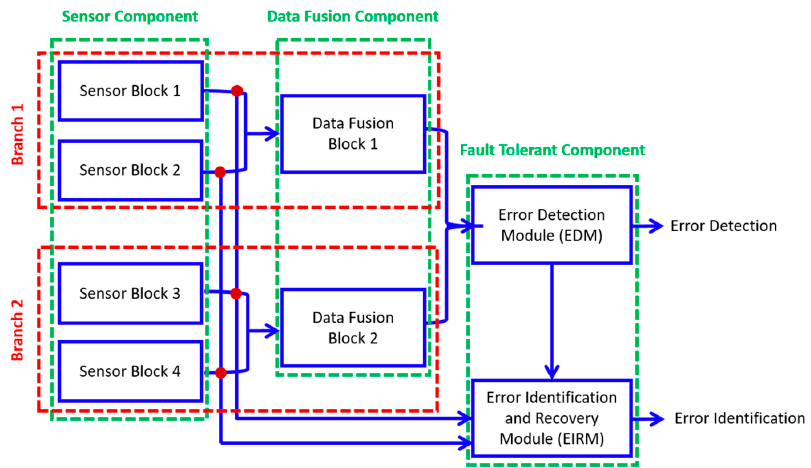
Figure 12. Duplication–comparison architecture for fault tolerance in multisensory perception .